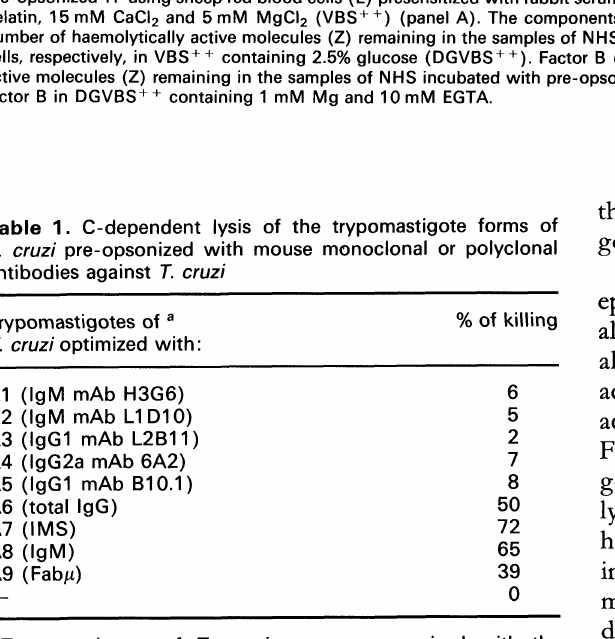
reincubated with NHS